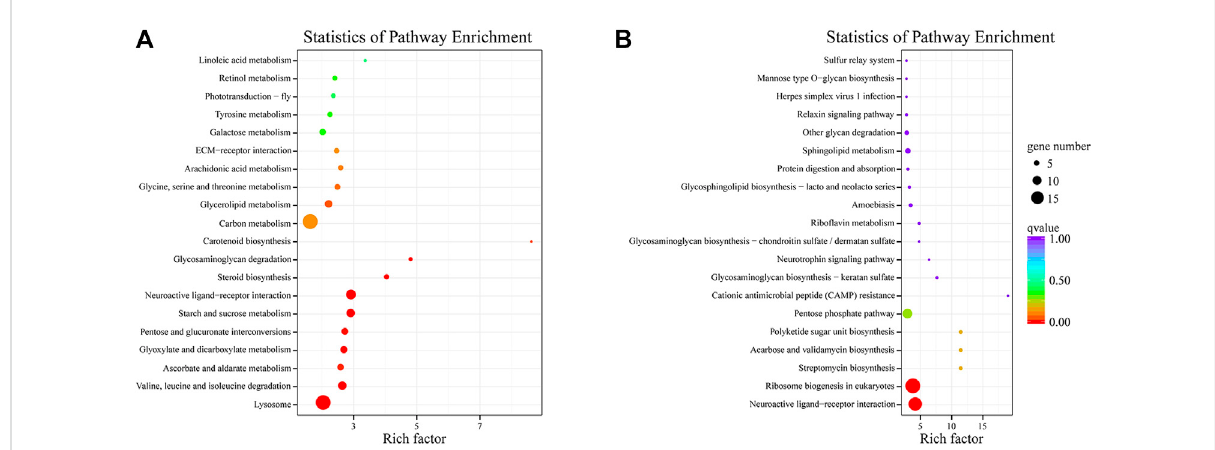
FIGURE 5 KEGG pathway analysis of DEGs. Note, Y -axis represents pathways and X -axis represents the enrichment score. (A) After exposure to fi pronil, the KEGG pathway enriched by DEGs was up-regulated. (B) After exposure to fi pronil, the KEGG pathway enriched by DEGs was down-regulated.